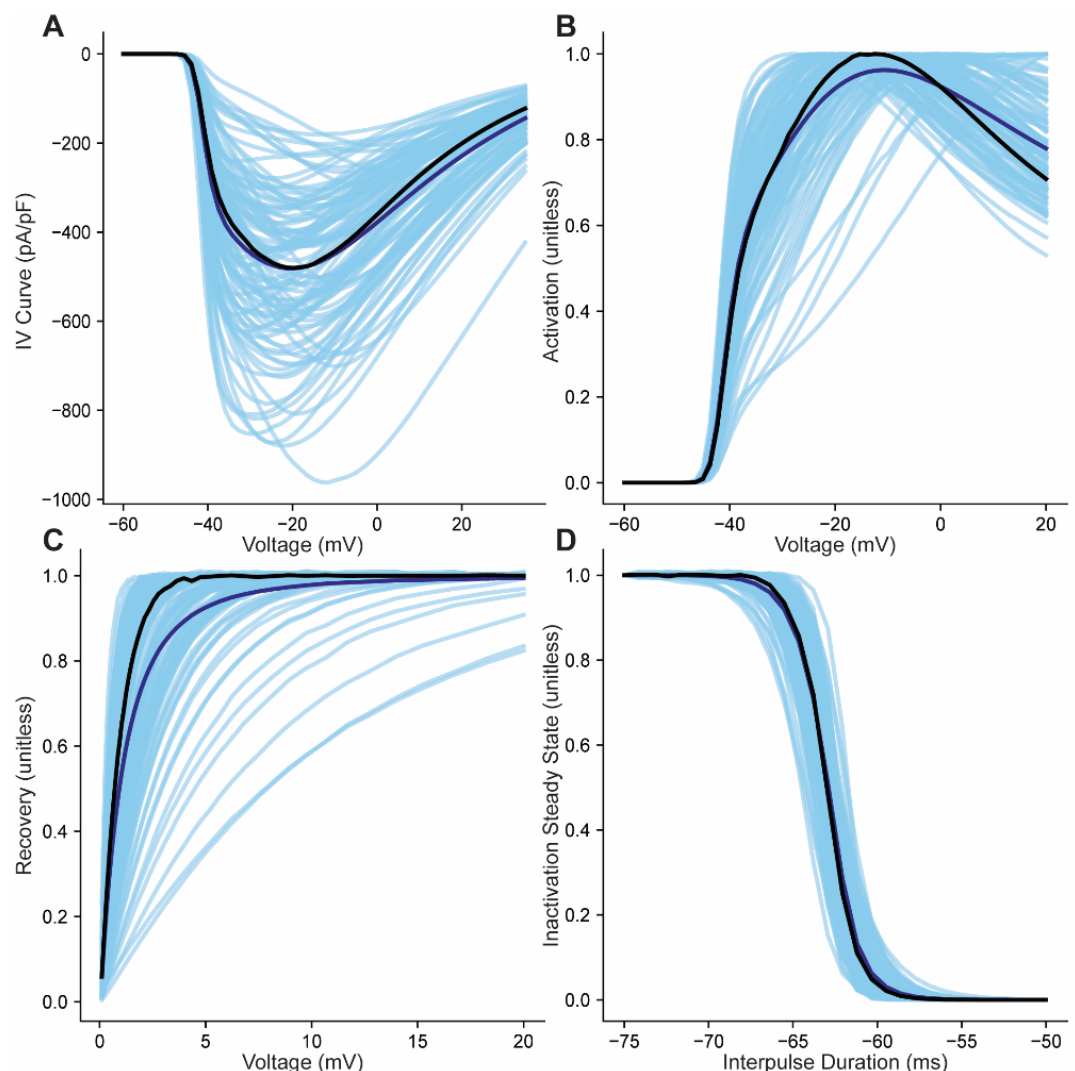
Figure 6. Simulation of model population at physiological temperature. ( A – D ) Current-voltage, steady-state activation, recovery from inactivation, and steady state inactivation curves from a population of models generated by randomly selecting 100 parameter sets from the fitted 25 dimensional multivariate normal distribution. The individual results from the 100 simulations (light blue lines) were used to generate a population mean (dark blue line) for each property and compared to the theoretical mean (black line) generated using the mean of the entire normal distribution. Simulations used the sodium concentrations and temperature used by the Grandi full sell AP model [9.1 and 140 mM, internal and external sodium, respectively, and temperature of 40 ◦ C (unlike previous simulations (Figures 3 and 4) that used room temperature to facilitate comparison to experiment (difficult to measure Na v 1.5 at body temp due to its rapid kinetics and large